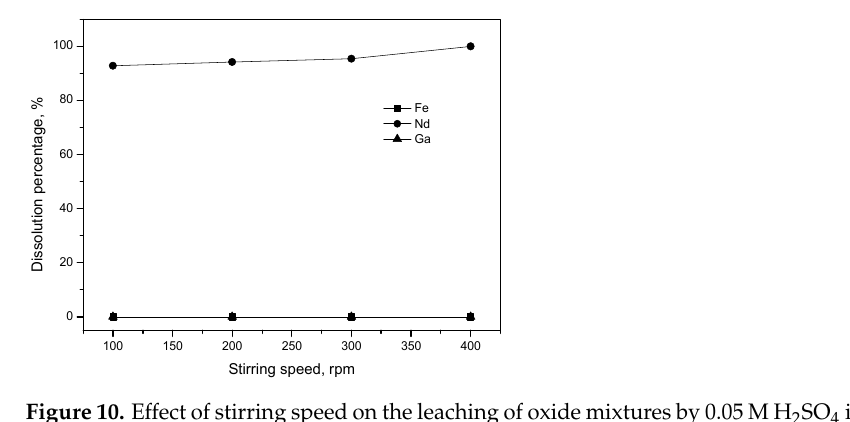
Figure 10. Effect of stirring speed on the leaching of oxide mixtures by 0.05 M H 2 SO 4 in EG. Operation conditions: pulp density = 50 g/L, T = 25 °C, time = 60 min.